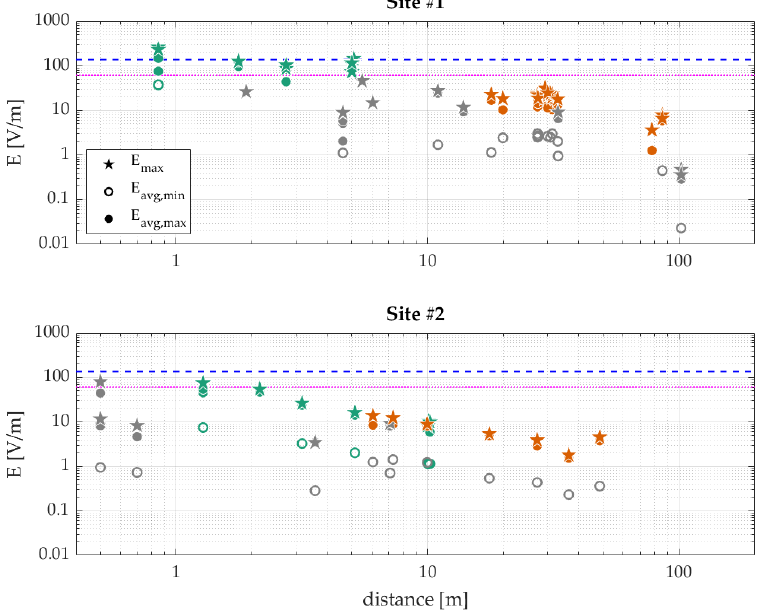
Figure 3. Three types of electric-field levels ( E avg,min as rings, E avg,max as circles, and E max as pentagons; all in V/m) measured at two sites with a 5G new radio (NR) base station as a function of the distance to the antenna with two types of measurement equipment, namely an FSV setup (green markers) and an SRM setup (orange markers) (markers in grey denote measurements outside the scanning range of the base station radio and were added for completeness rather than direct comparison). Maximum permissible exposure (MPE) limits issued by ICNIRP [17] are indicated by the blue dashed line (occupational) and the magenta dotted line (general public).